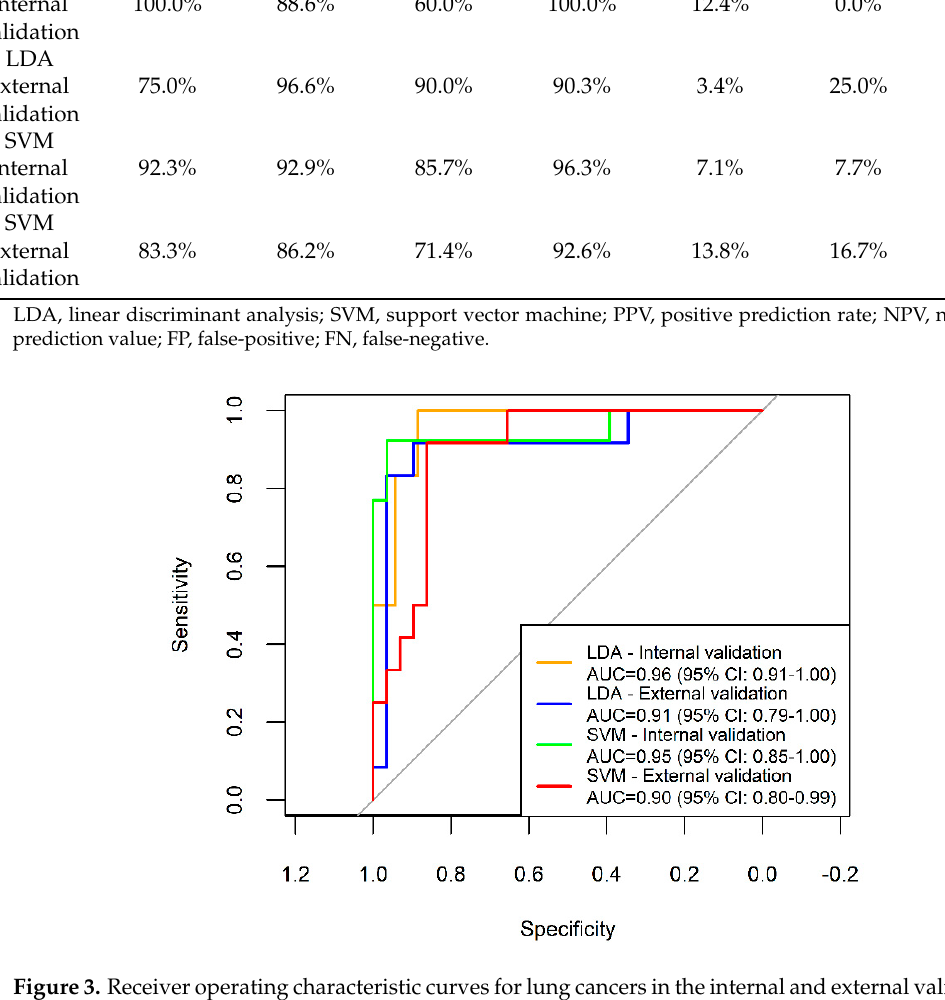
Figure 3. Receiver operating characteristic curves for lung cancers in the internal and external validation sets determined by LDA and SVM. The internal validation shows high accuracy by both linear and non-linear methods. The accuracy slightly decreases in the external validation.